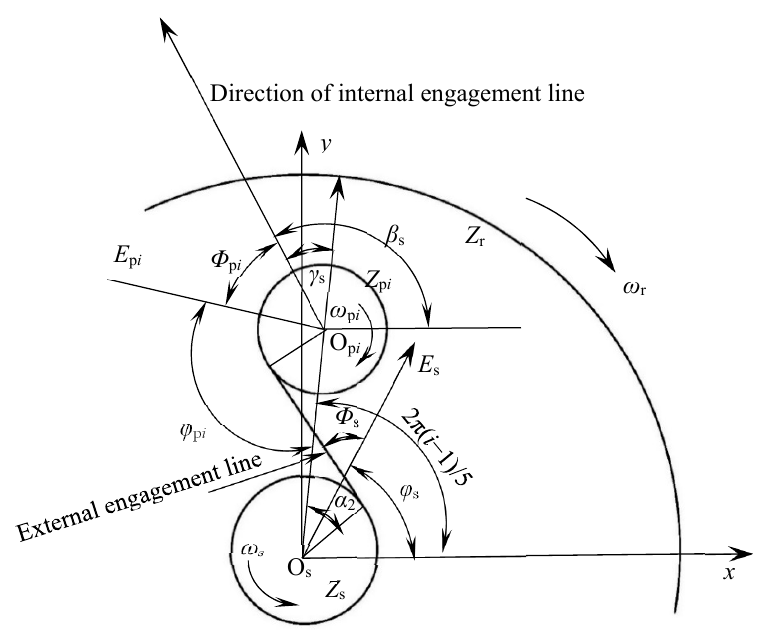
Figure 5. Diagram of gear meshing position relationship. When the installation error of the sun gear appears in the actual installation, the error causes the relative displacement of the meshing pair on each branch. In order to study the influence of the installation error on the five branches, the actual installation coordinate system is established as x ′ O s ′ y ′ . The connection line between the center of the star wheel and the sun gear on the first branch in the actual installation is the x ′ axis, as shown in Figure 6. Here, the assembly error of the sun gear is defined as the center deviation dis- tance A s and the error position angle γ s . Therefore, the coordinates of the actual center of the sun gear are: